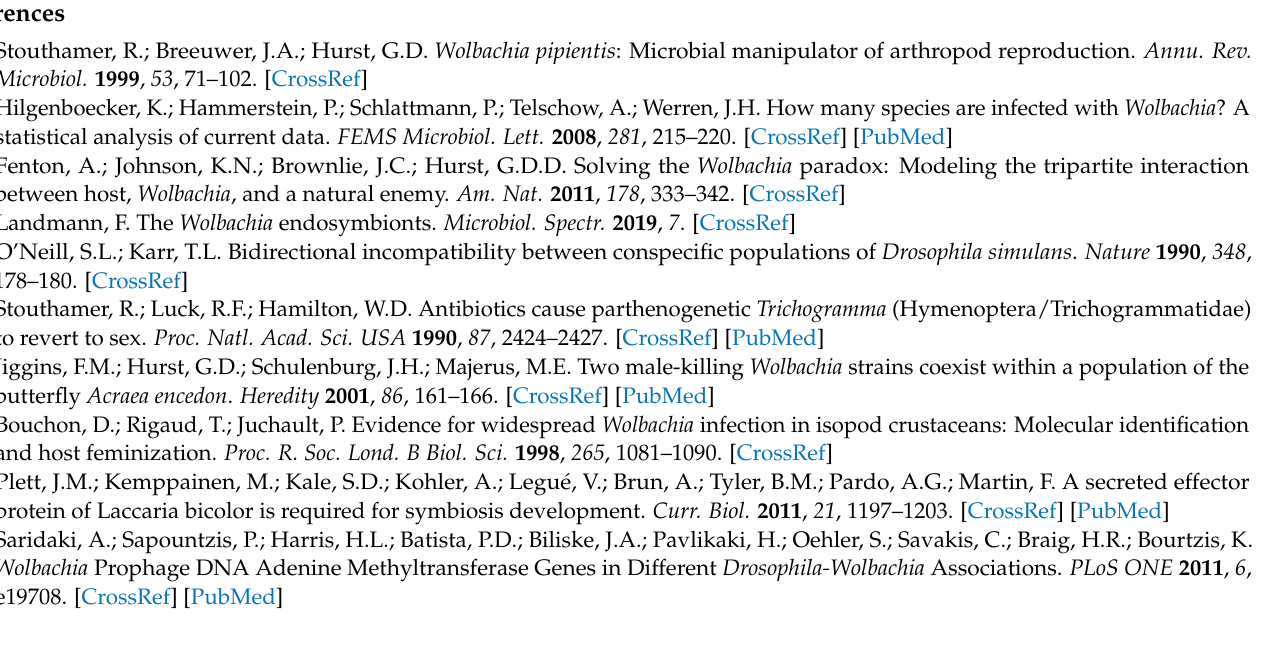
2T, Figure S2: PCR products of the orf7 gene fragments using WO-SUF and WO-SUR, Figure S3: Maximum likelihood tree for phage WO types of A. hakonensis based on orf7 protein sequence, Figure S4: The relative positions of all primers used in this article. Table S1: Genomes used for primer design in this